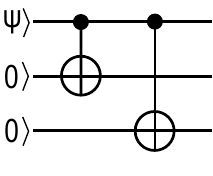
Figure 15: Circuit to extend one-qubit encoding to three-qubit